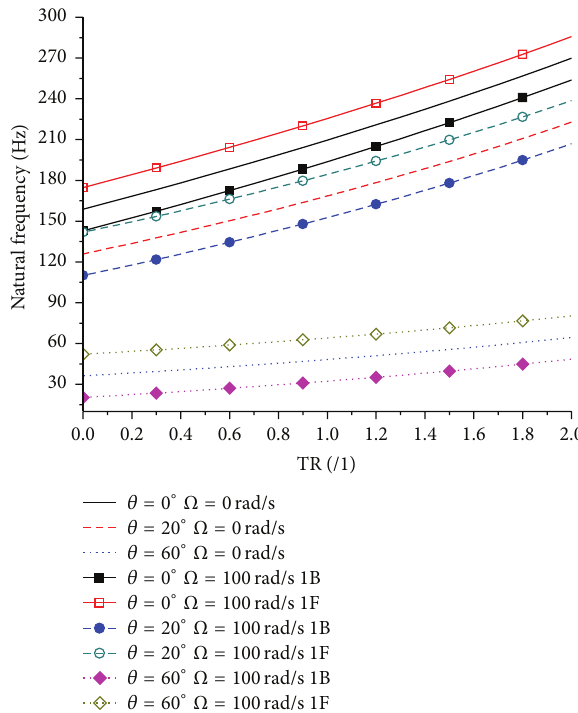
Figure 10: The first natural frequency versus taper ratio.